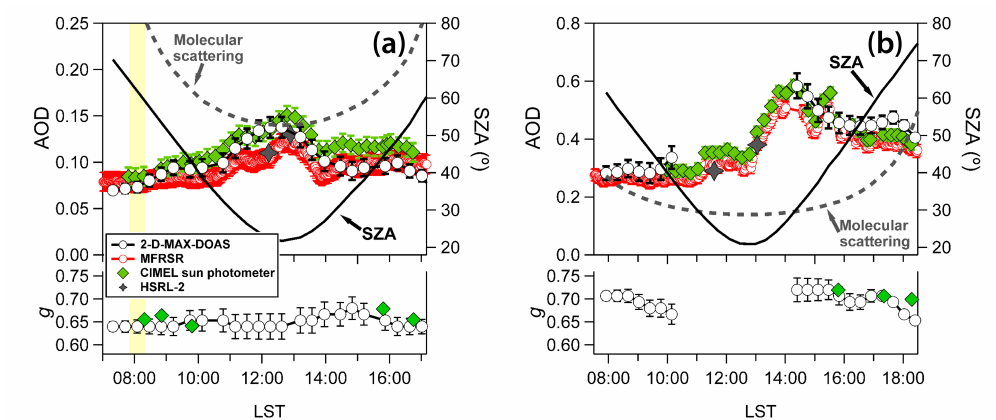
Figure 9. Time series of AOD comparing the 2-D-MAX-DOAS with MFRSR, CIMEL sun photometer, and HSRL-2 under (a) low AOD case on 22 July and (b) high AOD on 17 July. The dashed gray line represents the molecular optical depth. The retrieved g from 2-D-MAX-DOAS (430nm) and CIMEL (440nm) are shown in the bottom plot. The yellow shading in (a) represents the time period used in the example of Fig.